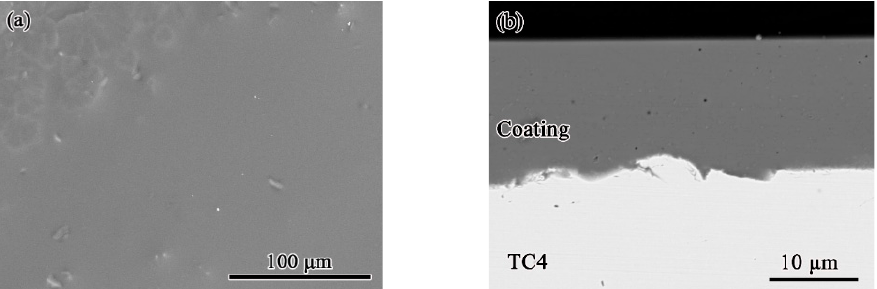
Figure 1. Surface ( a ) and cross ‐ sectional ( b ) morphologies of the SiO 2 ‐ Al 2 O 3 glass composite coating.